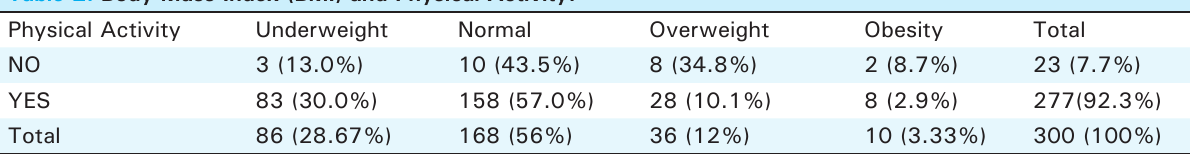
Table 2. Body Mass Index (BMI) and Physical